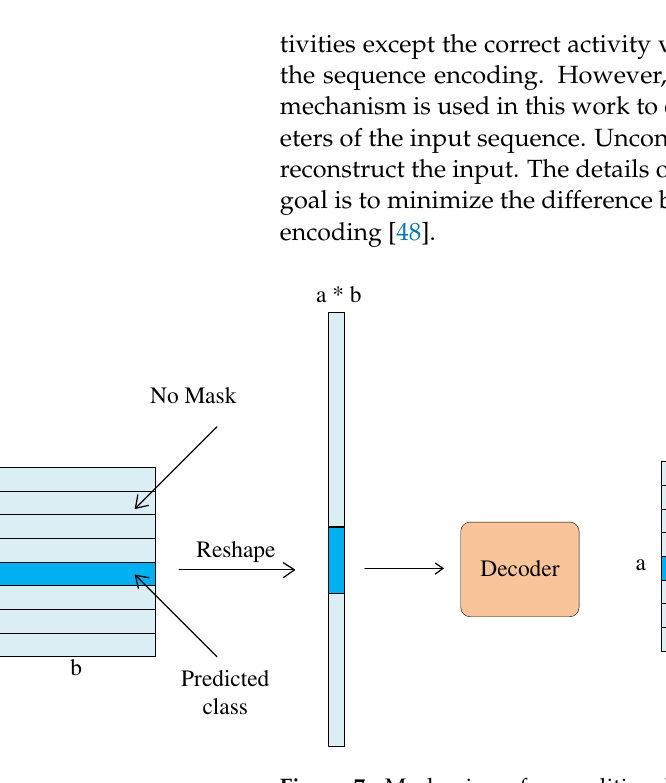
Figure 7. Mechanisms for conditional and unconditional decoders. The blue rectangular block represents the longest vector, and the gray color indicates that the vector is replaced by an all-zero